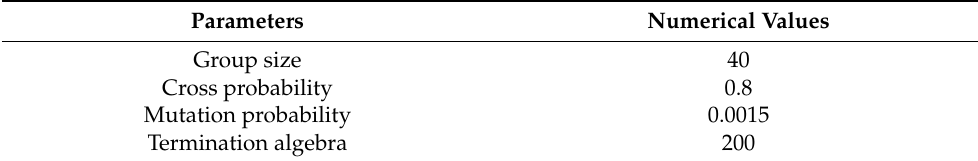
Table 8. Parameters setting of genetic the